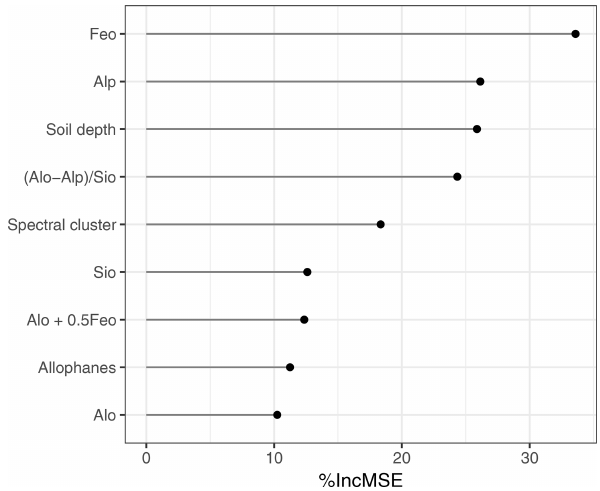
Figure 5. Relative importance (%IncMSE) of variables in the ran- dom forest model for the prediction of SOC